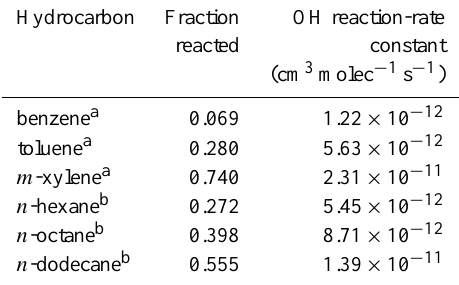
Table 1. Fraction of hydrocarbon reacted for an OH exposure of 58.3 × 10 9 moleccm − 3 s at 298K and 1atm. Hydrocarbons shown are abundant in a typical mixture of liquid gasoline and diesel fuel.